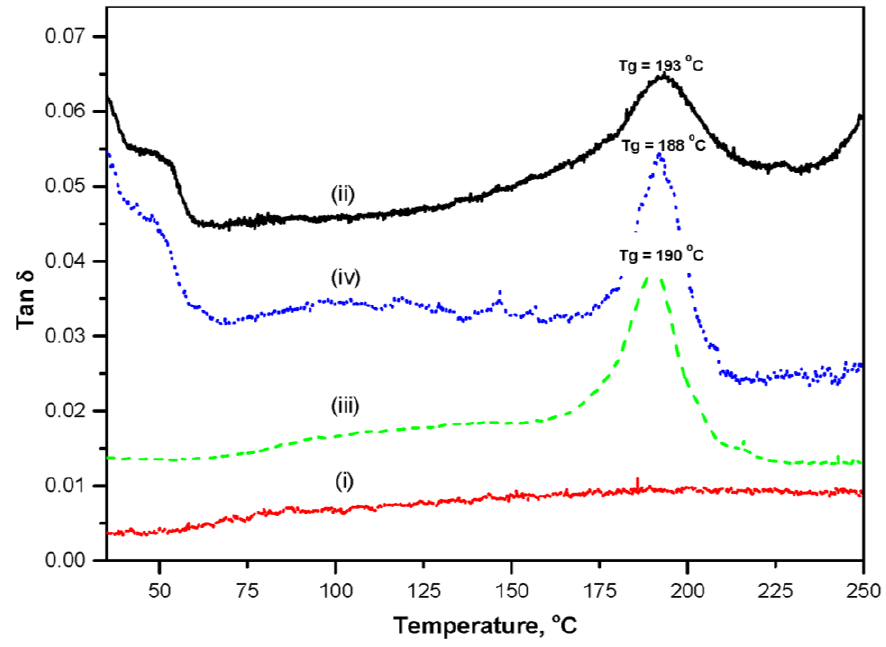
Figure 4. Dynamic mechanical analysis of (i) unmodified MFC; (ii) modified MFC; (iii) pure SMI and (iv) SMI/wax, curves are shifted along Y-axis to have the better